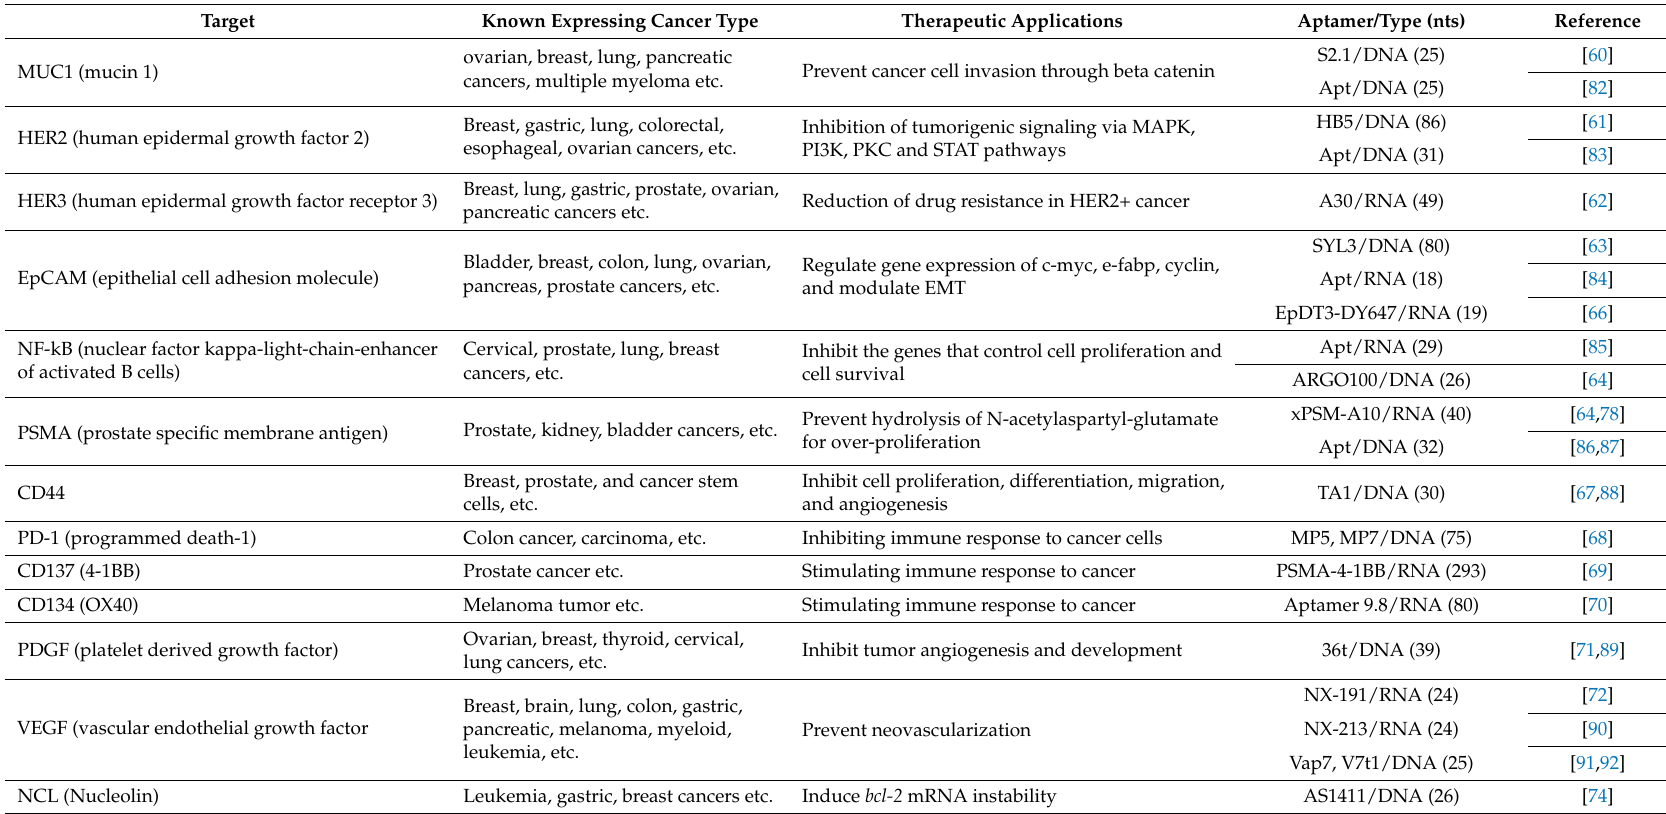
Table 1. Aptamers targeting cancer-related